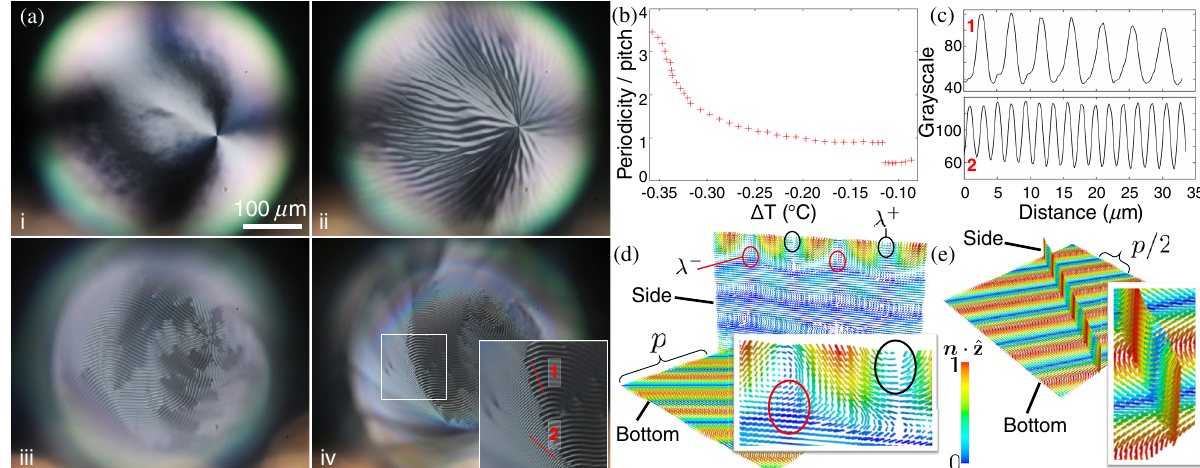
FIG. 3. Unbending transition under increasing confinement. (a) Micrographs show a CLC shell with initially planar anchoring (i) heated towards the isotropic phase transition temperature with concomitant thinning of the cholesteric shell and introduction of weak out-of-plane anchoring. As the isotropic layer expands, thick planar stripes form initially (ii) and continuously decrease to the size of the pitch (iii), at which point, the stripe narrows discontinuously to the size of a half-pitch (iv), until the entire shell transitions to the isotropic phase (see Video 3 in Ref. [32]). The pitch is 5 μ m; the radius ( R ) and thickness ( h ) of the shell are R ∼ 200 μ m and h ∼ 1 μ m. (b) Stripe periodicity over pitch versus temperature difference to the phase transition temperature. A continuous decrease followed by an abrupt halving is clearly seen. (c) Grayscale values of stripes in (a-iv) before (red line, 1) and after (red line, 2) the front of the unbending transition, showing the halving of the stripe periodicity. (d) Simulation of a 0 . 81 × 0 . 81 × 0 . 54 - μ m CLC slab with a 0 . 28 - μ m pitch, moderate homeotropic anchoring ( W 0 ≈ 8 × 10 − 5 J = m 2 ) on the top and bottom, and periodic boundary conditions in the horizontal directions. The outermost cholesteric layers are bent, yielding a stripe periodicity greater than the pitch. Alternating λ þ and λ − pitch defect lines are labeled. The director color indicates the magnitude of the director along the vertical direction, ˆ z . (e) When the slab thickness decreases from 0.54 to 0 . 13 μ m (around half-pitch), the CLC unbends and runs parallel to the interface, creating half-pitch- wide